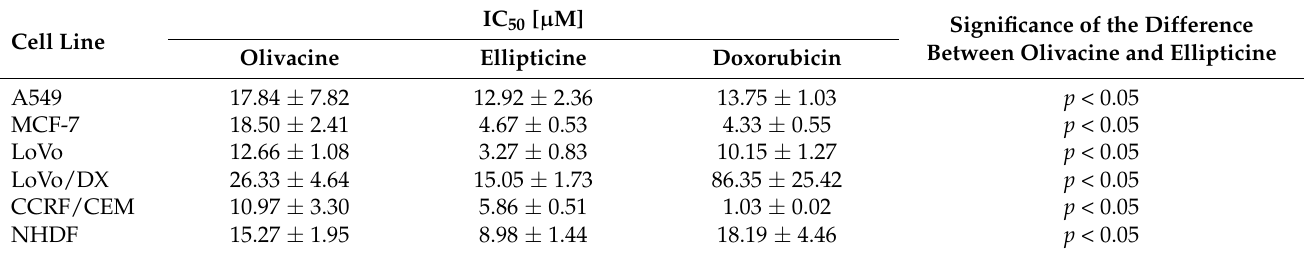
Table 2. MTT assay results (IC 50 values) after treatment with olivacine or ellipticine in A549, MCF-7, LoVo, LoVo/DX, CCRF/CEM, and NHDF cells.